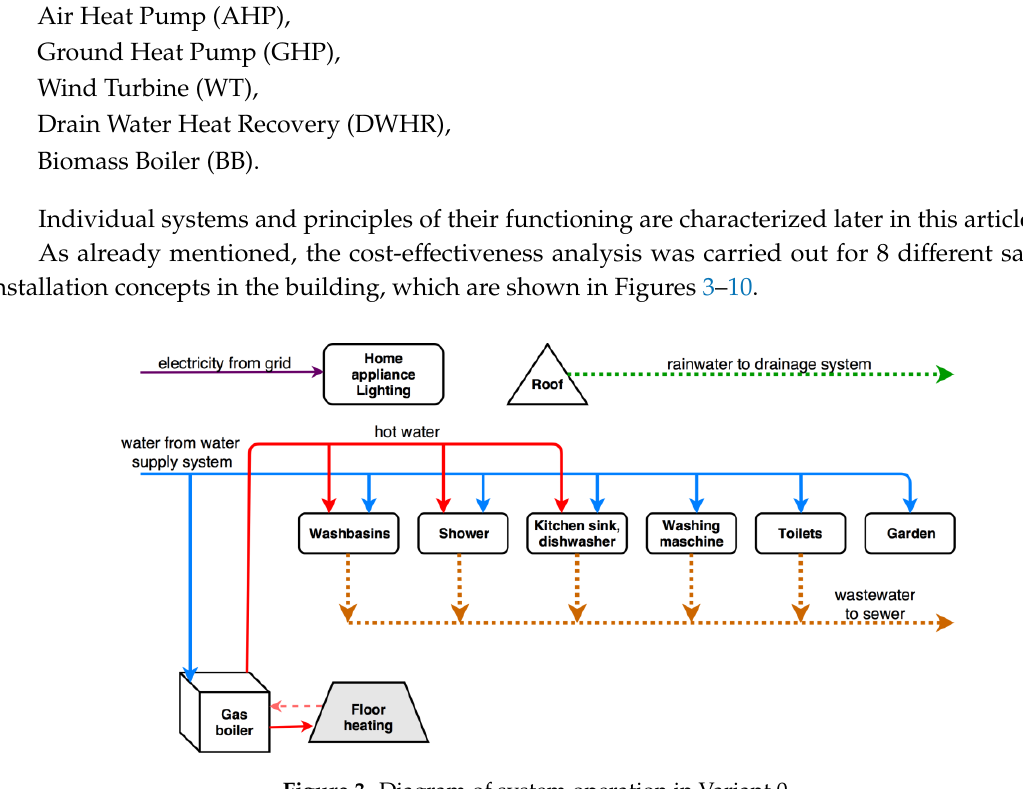
Figure 4. Diagram of system operation in Variant 1. Figure 5. Diagram of system operation in Variant 2.